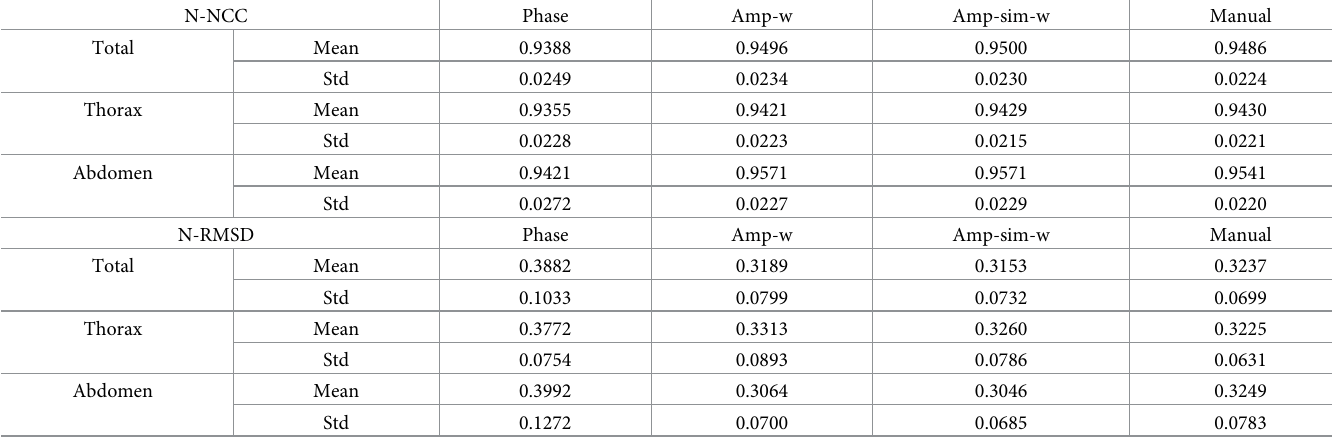
Table 6. Mean and standard deviation of a) N-NCC and b) N-RMSD, respectively, in the sorted 4DCT according to the sorting algorithm. N-NCC Manual